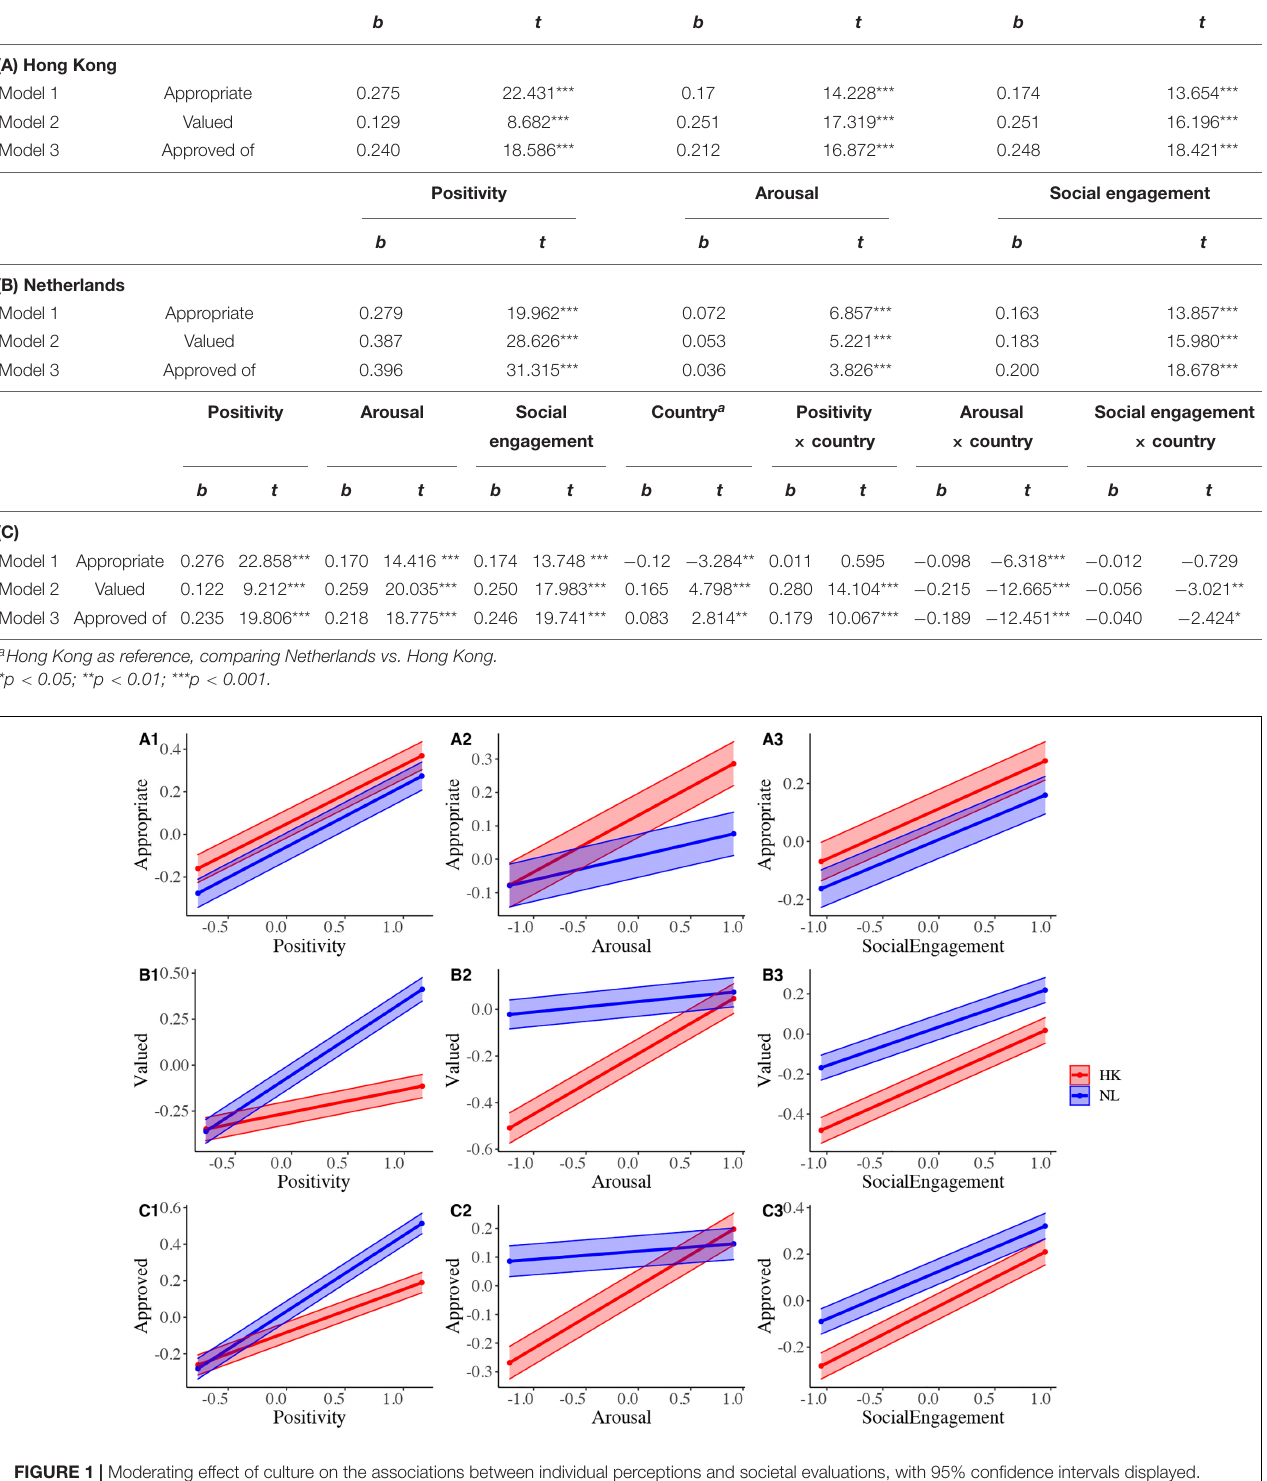
Frontiers in Psychology |